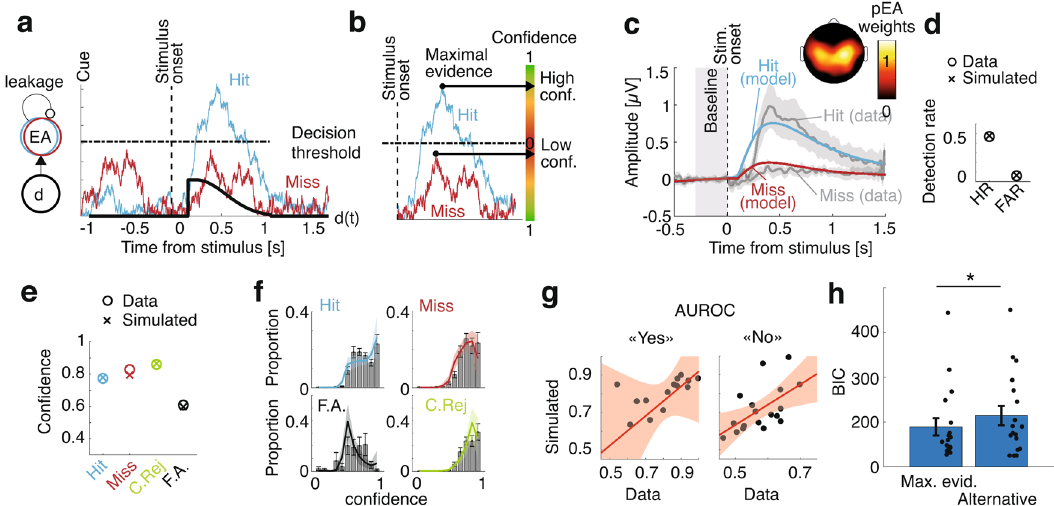
Fig. 4 Computational model based on evidence accumulation. a Simulation: Time-varying drift rate (d; thick black trace) had a short-lasting boost after a non-decision time following stimulus onset (dashed vertical line). Example evidence accumulation for one trial (EA; blue trace for a hit, red trace for a miss) rises sharply after the drift boost and is attracted back to zero due to leakage. A stimulus is considered as perceived (hit) if EA reaches a decision threshold (horizontal line), and as non-perceived (miss) if not. b The maximum of accumulated evidence with respect to the decision threshold is used as a con fi dence readout. In the example in a , the blue trace results in high con fi dence in a hit (large distance from the bound) and the red trace results in low con fi dence in a miss (small distance from the bound). c Model fi t of the proxy to EA (pEA) locked on stimulus onset for hits (blue trace) and misses (red trace). The corresponding observed EEG data for hits (upper line) and misses (lower line) is shown in grey. Average scalp topography of normalized pEA weights is shown above. Shaded areas represent 95%-CI. d Hit rate (HR) and false-alarm rate (FAR). Datapoints are represented as ‘ o ’ and model simulations as ‘ x ’ . e Average con fi dence for hits (cyan), misses (red), correct rejections (green) and false alarms (black). f Model fi ts of the con fi dence distributions. Histograms show con fi dence distributions with 95%-CI whiskers. Colored traces show model simulations. All shaded areas represent 95%- CI. The y axis represents the proportion of trials. g Area under the receiver operating characteristic curve (AUROC) correlation between observed data (horizontal axis) and simulated data (vertical axis) for “ yes ” responses (hits and false alarms; left) and “ no ” responses (correct rejections and misses; right). Regression line is shown in red with shaded areas representing 95%-CI). h Model comparison in terms of Bayesian information criterion (BIC) between the maximal evidence model and the alternative model. Whiskers represent 95%-CI and asterisk indicates statistical signi fi cance ( p = 0.0020, N = 18 participants, Wilcoxon signed